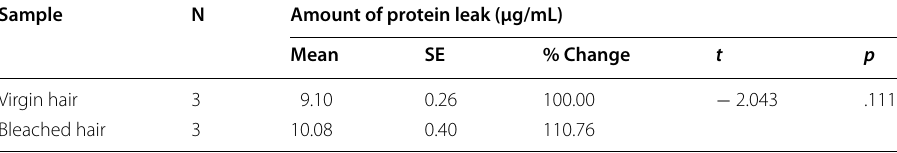
Table 6 Amount of protein leak from virgin hair and bleached hair and the results of t -test Sample N